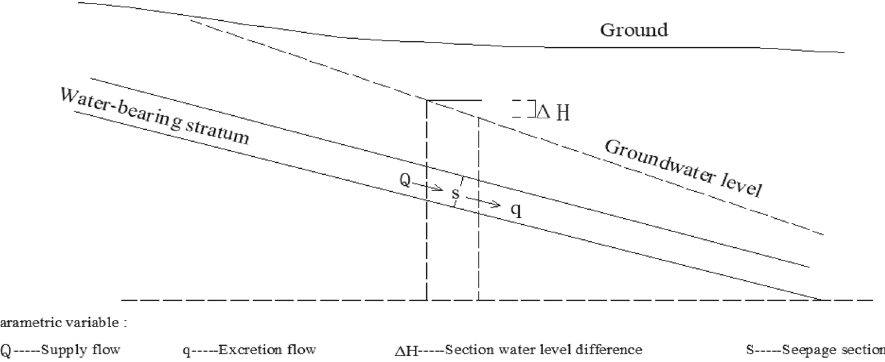
Figure 1. Schematic diagram of the relationship among water level difference, recharge flow and seepage flow.